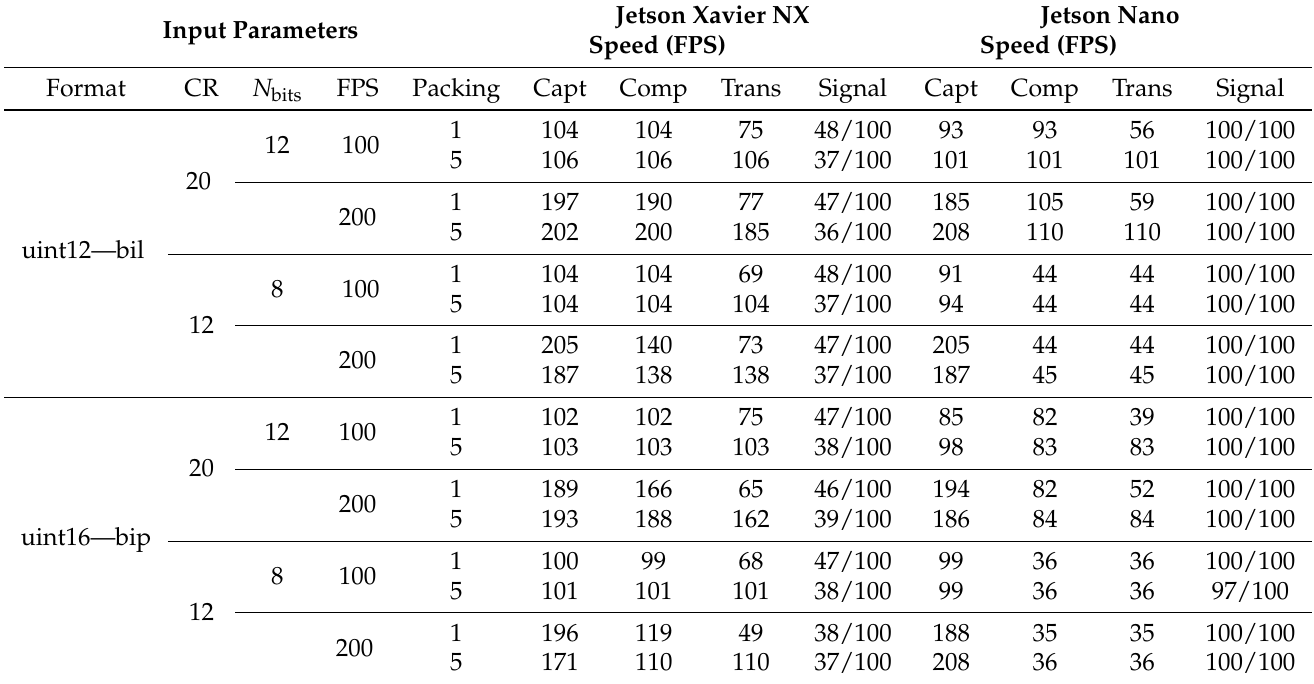
Table 6. Speed results for the proposed design.